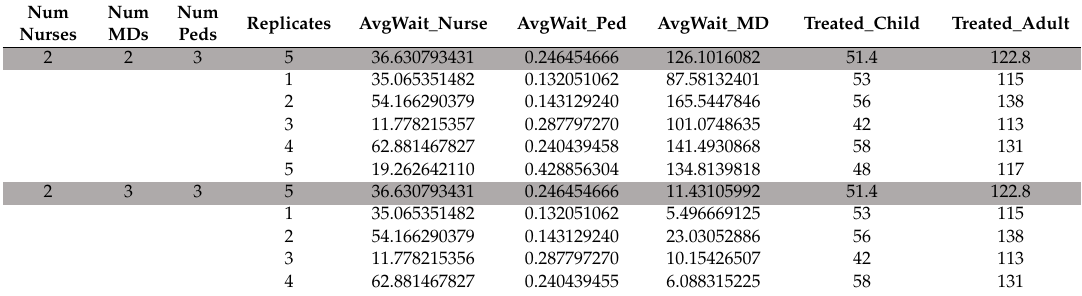
Figure 7. Simulation model when 15 adult patients arrive per hour (with increase in staffing). Table 3. Avgerage waiting time for an adult patient with and without an additional doctor.